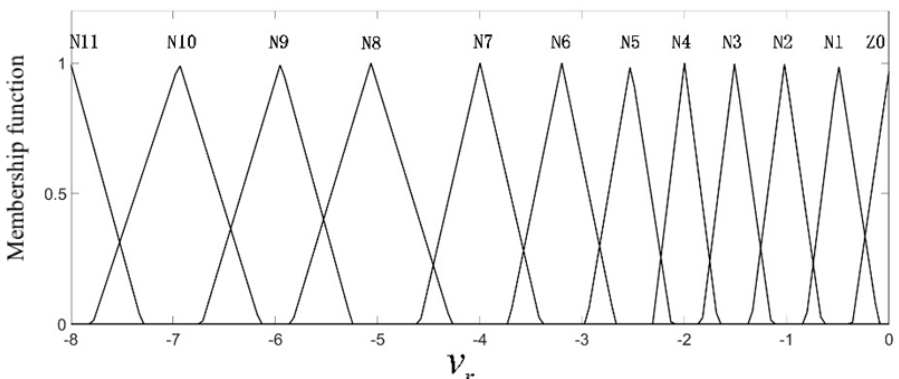
Figure 10. The membership function of the longitudinal relative velocity.